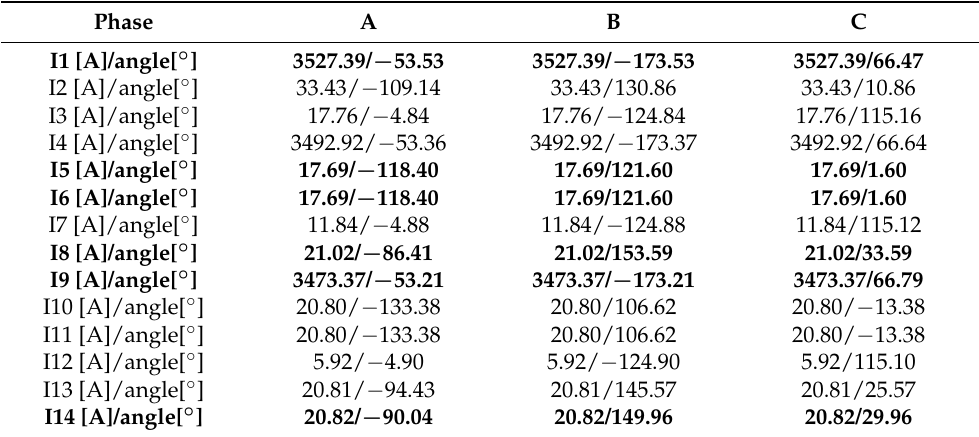
Table 3. The Fault Calculation Results for 3LG Fault at the Bus 9 in grid-connected mode of